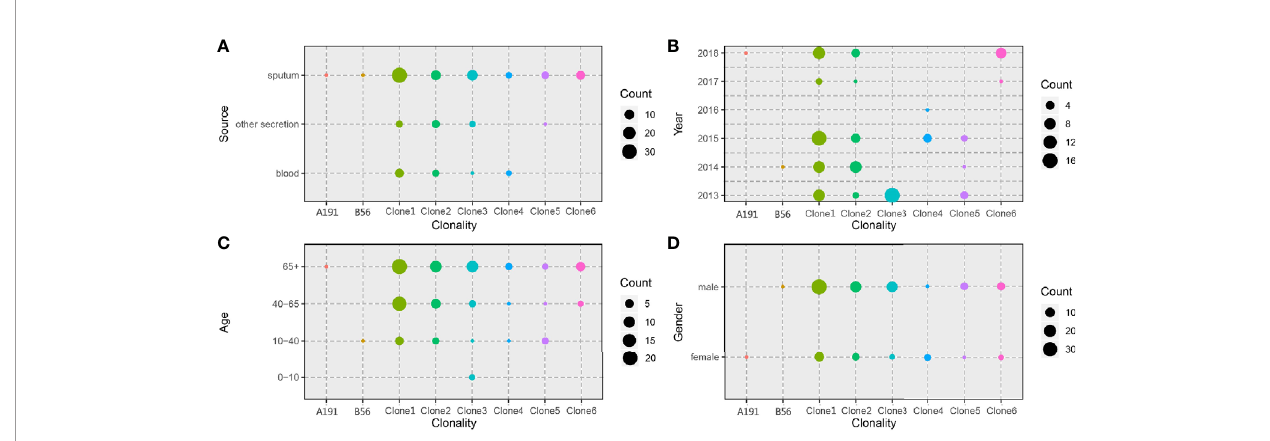
FIGURE 5 | Distribution of CRAB clonalities in different spatial temporal, demographic, and clinical characteristics. (A) Distribution of CRAB clonalities in different sampling sources. (B) Distribution of CRAB clonalities in different sampling years. (C) Distribution of CRAB clonalities in different patient ages. (D) Distribution of CRAB clonalities in different patient